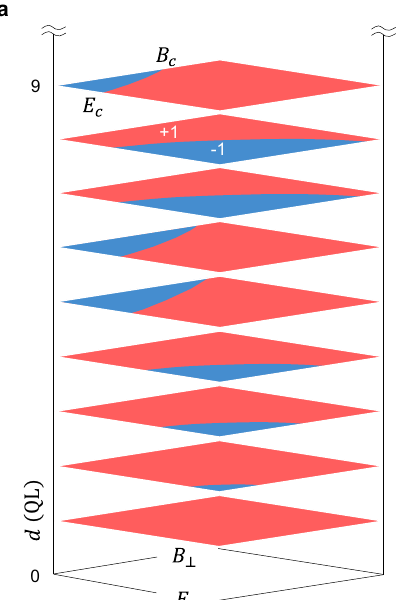
Fig. 1 | Topologicalphase transitions.a Topological phase diagrams for parity of the surface hybridization gap modulated by external magnetic and electric fi elds acting perpendicular to the c-axis plane of the variable thickness hBSTS. The red andbluecolorcodesrepresenttheoppositesignofparityasarepresentationofthe normal and inverted surface hybridization gaps, respectively. The zero- fi eld gap parity isdetermined by DFT. The diagrams are drawn based on the Hamiltonian of topological surface states H SOC under distortions of magnetic H Z and electric H U